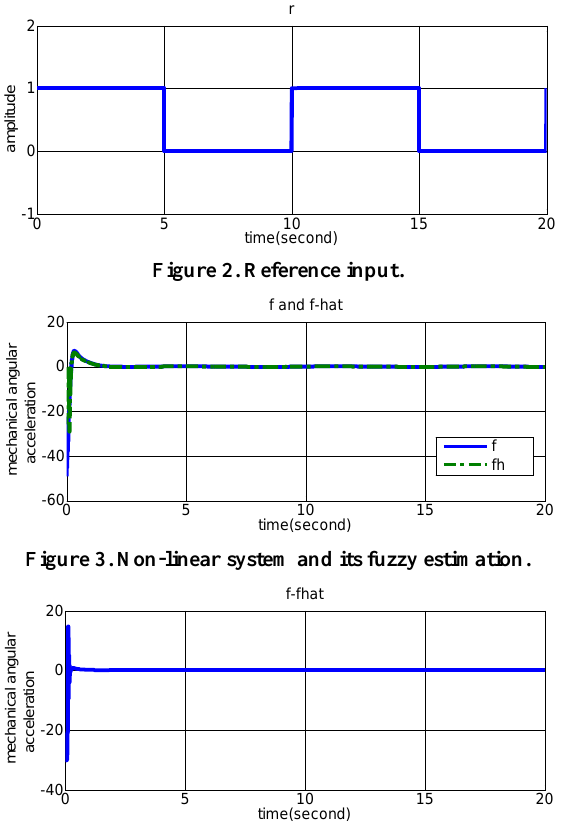
Figure 9. First state and its estimation.